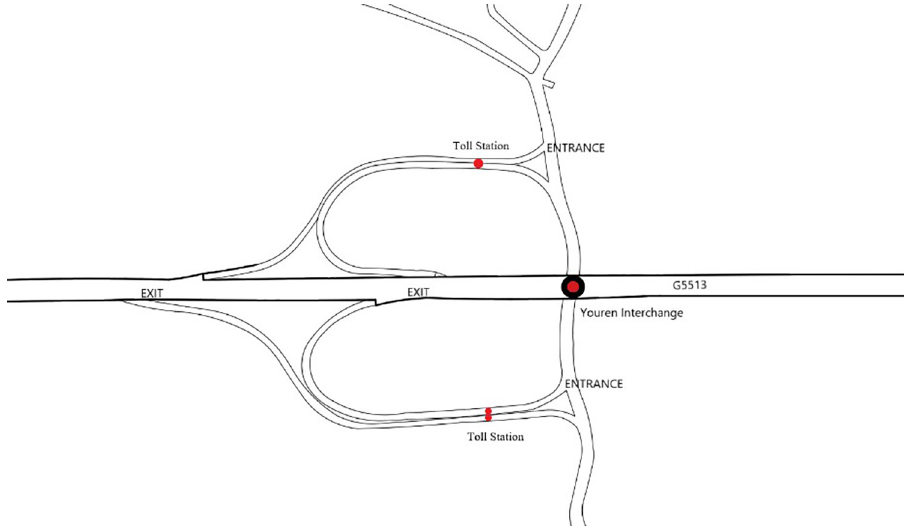
Fig 3. Layout of Youren Interchange.